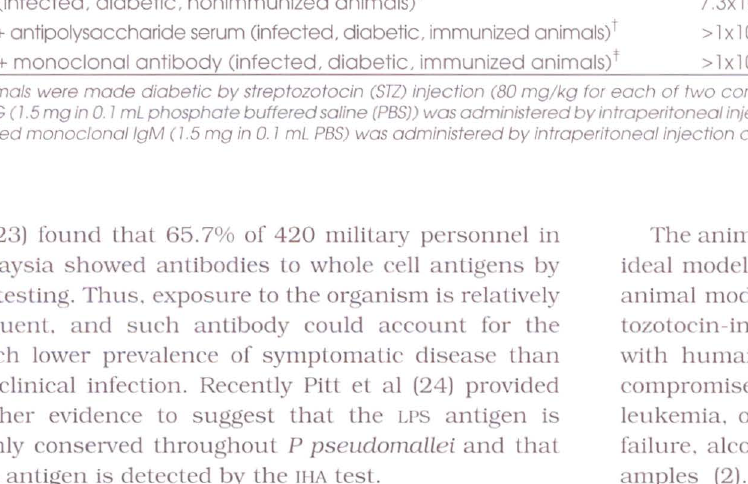
Median lethal dose values for rats infected with Pseudomonas pseudomallei